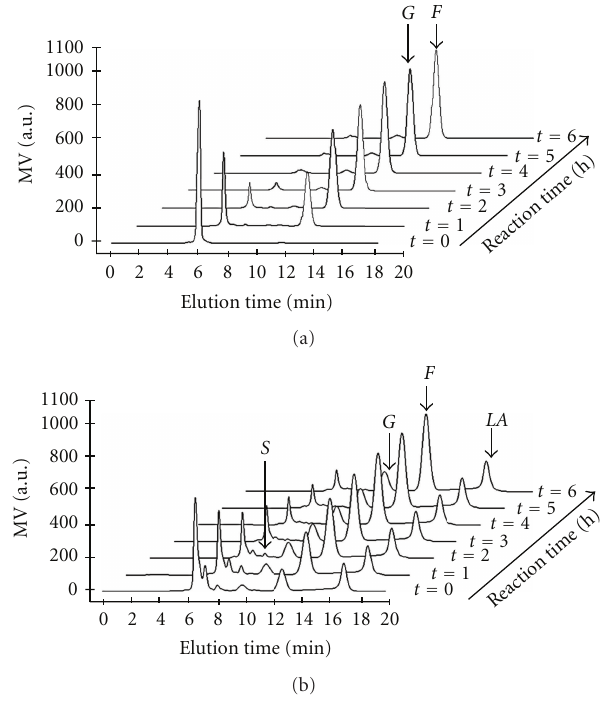
Figure 4: Chromatographic representation of substrates degrada- tion and release of sugars during the enzymatic hydrolysis. (a) Chicory inulin, (b) agave fructan. S : sucrose, G : glucose, F : fructose, LA : lactic